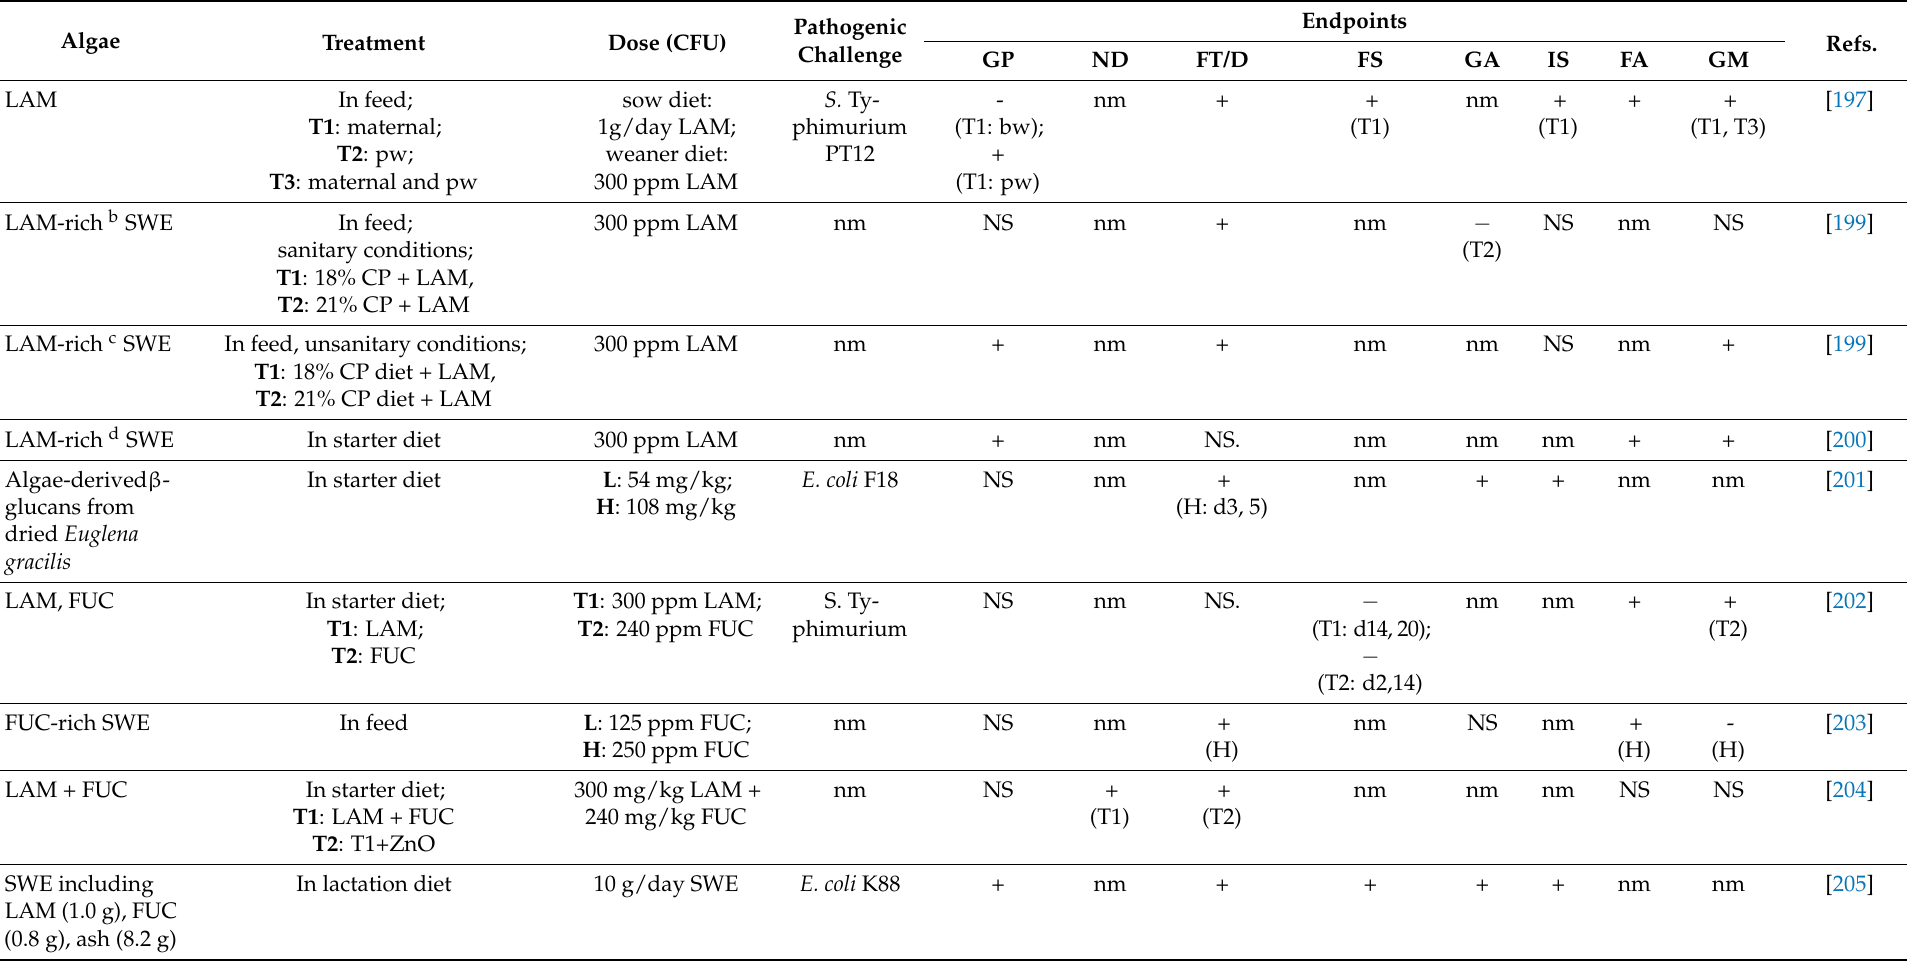
Table 7. Effects of algae on various parameters in piglets a